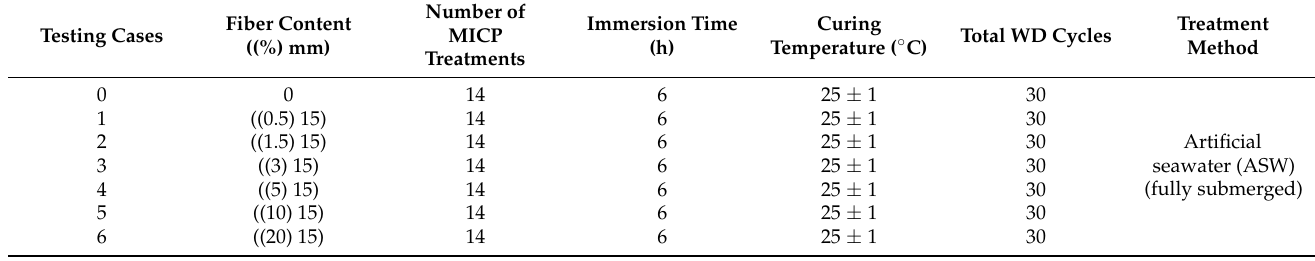
Table 3. Testing conditions used in this study for durability analysis (ASW cases).